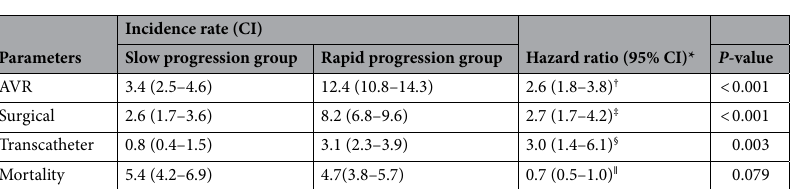
Table 2. Incidence rates and risk of each outcome in the two trajectory groups. AVR aortic valve replacement, CI confidence interval. *Hazard ratios for rapid progression group vs slow progression group. † Adjusted with group type, age (10 years), peripheral arterial occlusive disease, chronic kidney disease, atrial fibrillation, rheumatic heart disease, initial mean pressure gradient. ‡ Adjusted with group type, age (10 years), hypertension, dyslipidemia, coronary artery disease, coronary artery bypass graft, initial mean pressure gradient. § Adjusted with group type, age (10 years), hypertension, dyslipidemia, diabetes, peripheral arterial occlusive disease, chronic kidney disease, coronary artery disease, coronary artery bypass graft, rheumatic heart disease, bicuspid aortic valve, aortic regurgitation. ∥ Adjusted with group type, sex, age (10 years), hypertension, diabetes, peripheral arterial occlusive disease, stroke, chronic kidney disease, chronic obstruction pulmonary disease, coronary artery disease, coronary artery bypass graft, heart failure, rheumatic heart disease, bicuspid aortic valve, aortic